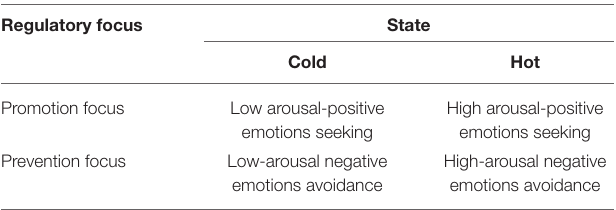
TABLE 1 | Scenarios of the relationship between hot–cold states and promotion/prevention-focus in emotionally affected cognitive states. Regulatory